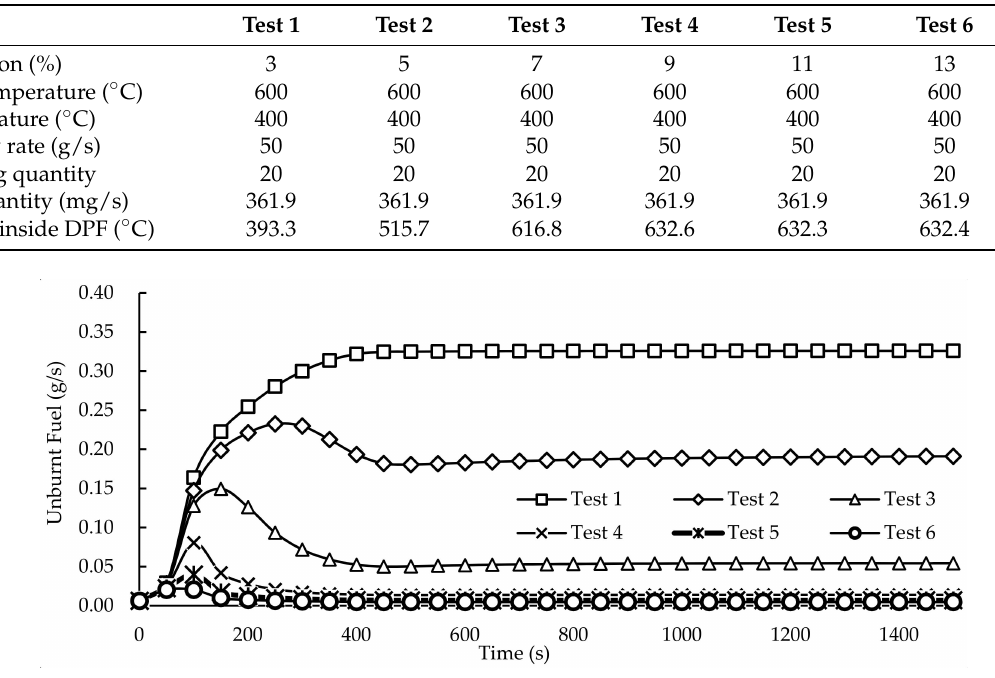
Figure 13. Unburnt fuel analysis with different oxygen